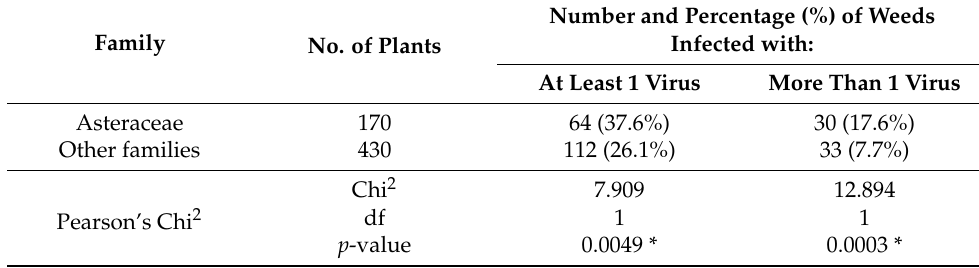
Table 4. Number and percentage of weeds infected with one or more than one virus and belonging to Asteraceae family vs. other families.